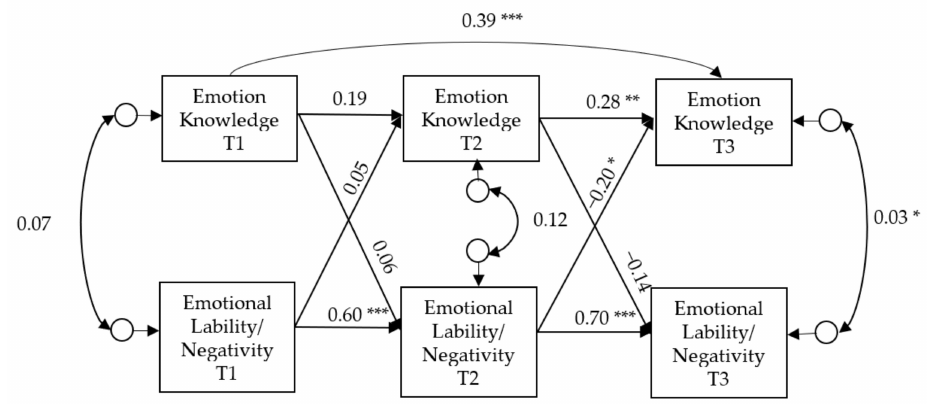
Figure 2. Cross-lagged model for testing the longitudinal association between emotion knowledge and emotion lability / negativity across the three measurement times. Values are standardized coe ffi cients. * p < 0.05; ** p < 0.01; *** p < 0.001. Only one cross-lagged e ff ect from L / N (T2) to EK (T3) was statistically significant ( − 0.20, p < 0.05). There were no significant cross-lagged e ff ects from EK to L /